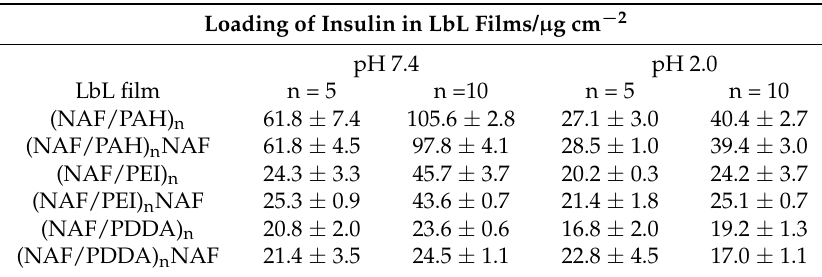
The LbL films were exposed 1 mg mL − 1 insulin with 10 mM acetate buffer (pH 2.0) or 10 mM Tris buffer (pH 7.4). All buffer solutions contained 150 mM